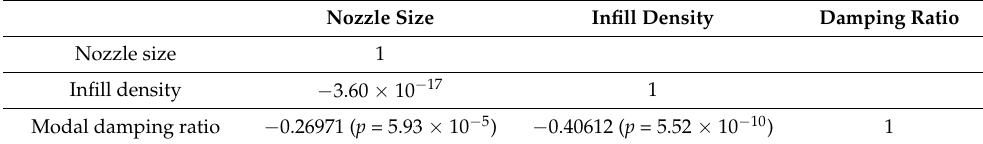
Table 3. Correlation analysis results for nozzle size and infill density.